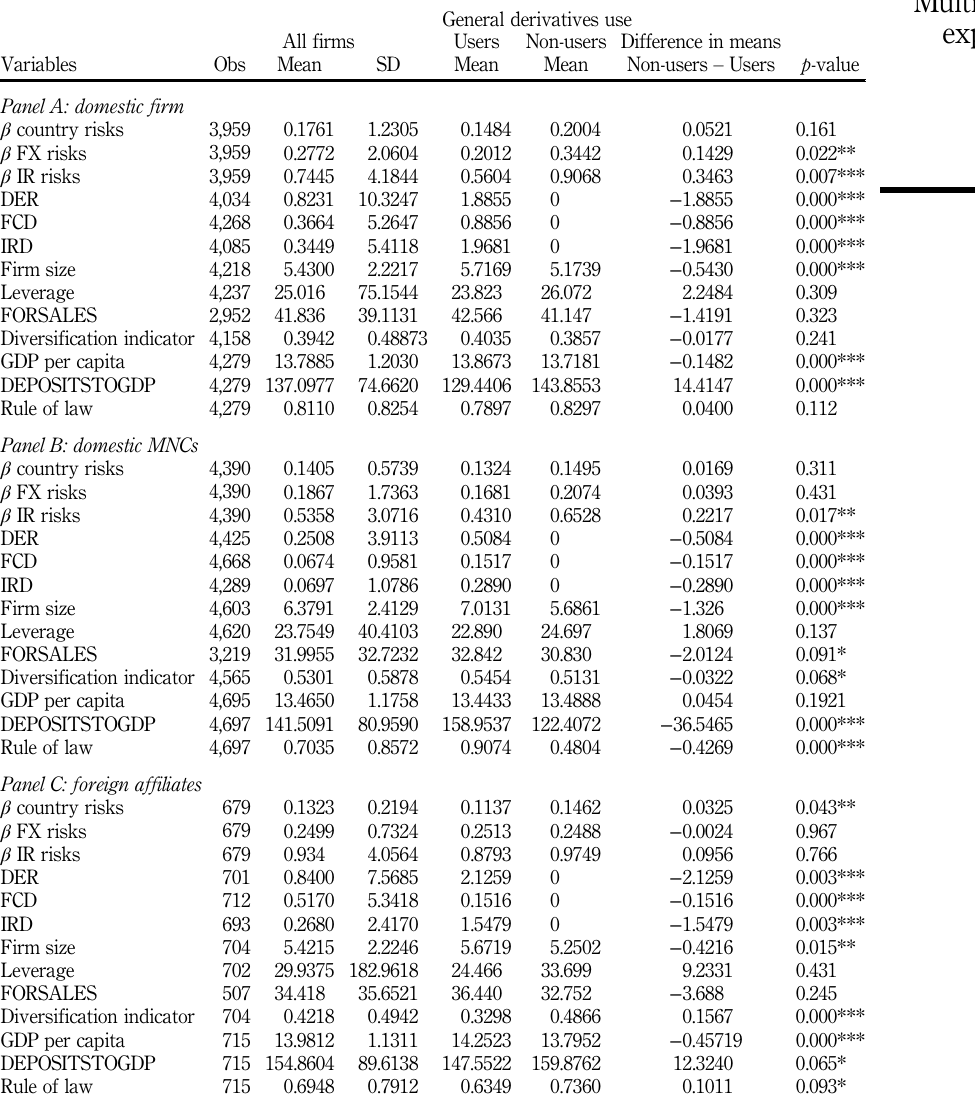
Table III. Summary